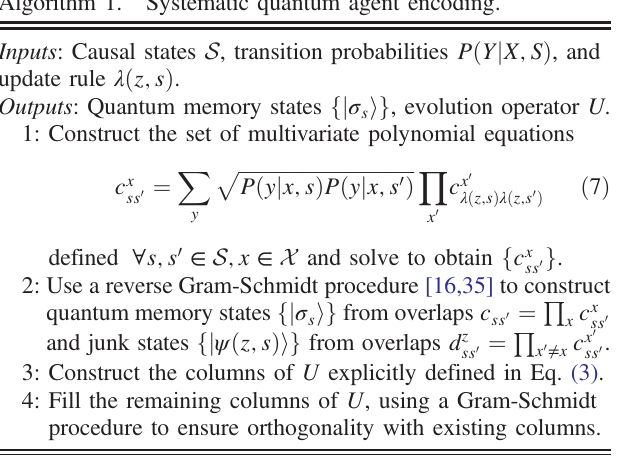
Algorithm 1. Systematic quantum agent encoding.